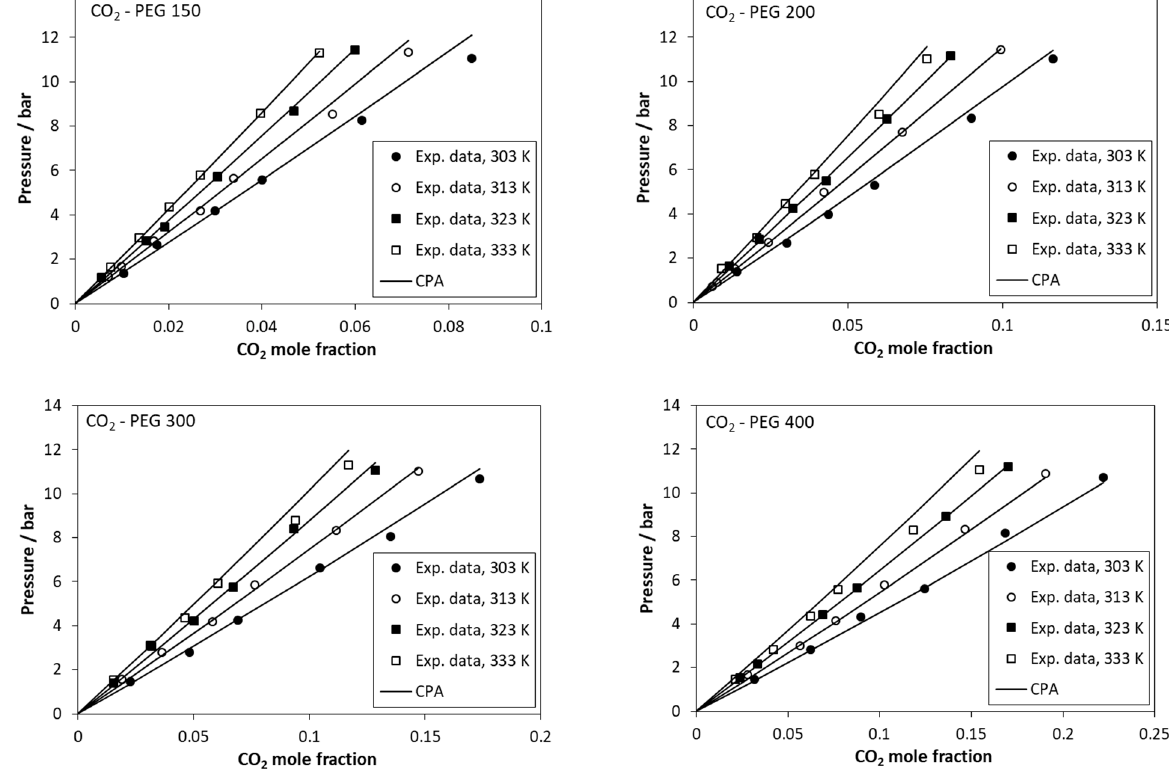
Figure 2. Solubility of CO 2 in polyethylene glycols. Experimental data (points [38]) and CPA calculations (lines) using the k ij values of Table 3.